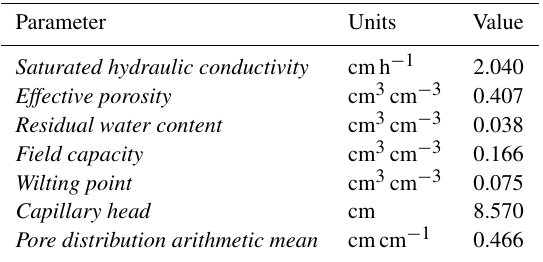
Table 3. Values of soil parameters used to calculate soil moisture in the single-layer Green and Ampt infiltration